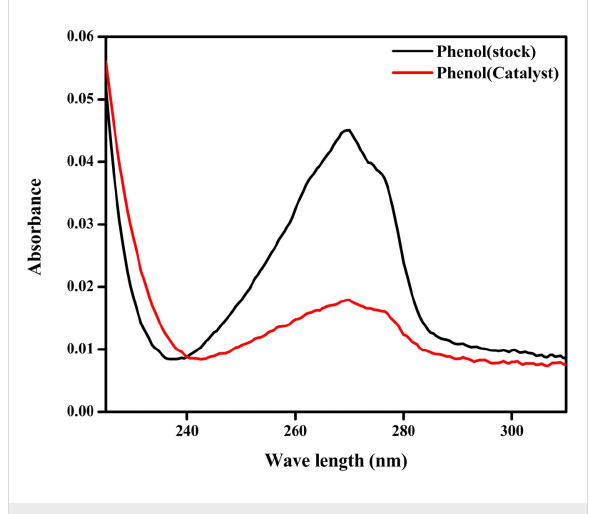
Figure 14: Adsorption spectra of the phenol solution before and after photodegradation over ZFO-500.